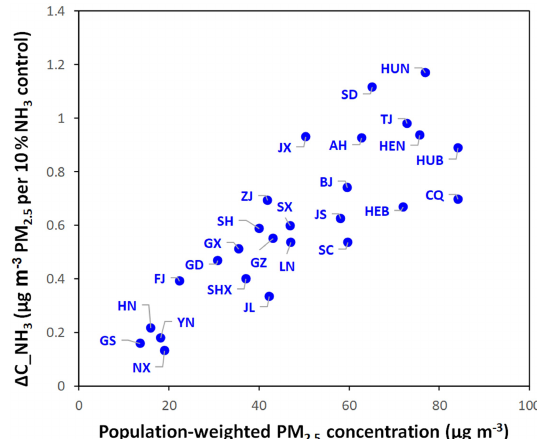
Figure 13. Comparison of annually averaged benefit in reduc- ing PM 2 . 5 from simultaneous NH 3 reduction ( (cid:49) C_NH 3 ) and population-weighted PM 2 . 5 concentration in each province in